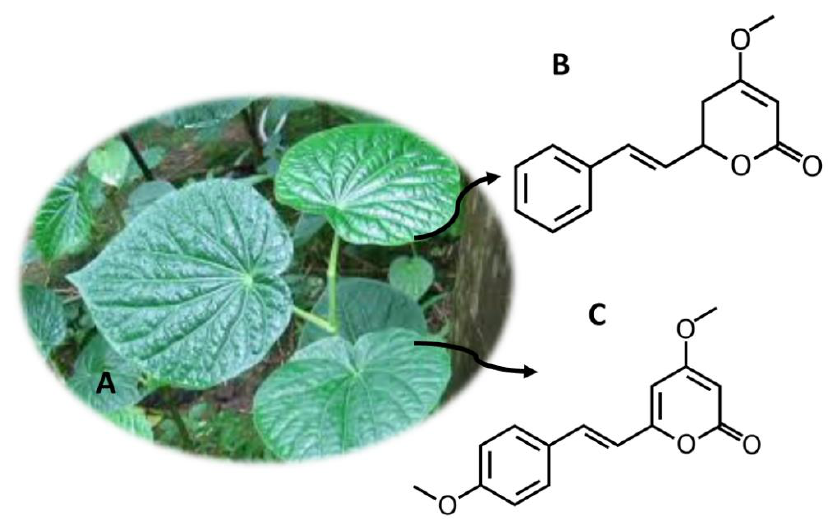
Figure 9. P. methysticum ( A ) and the main compounds kavain ( B ) and yangonin ( C